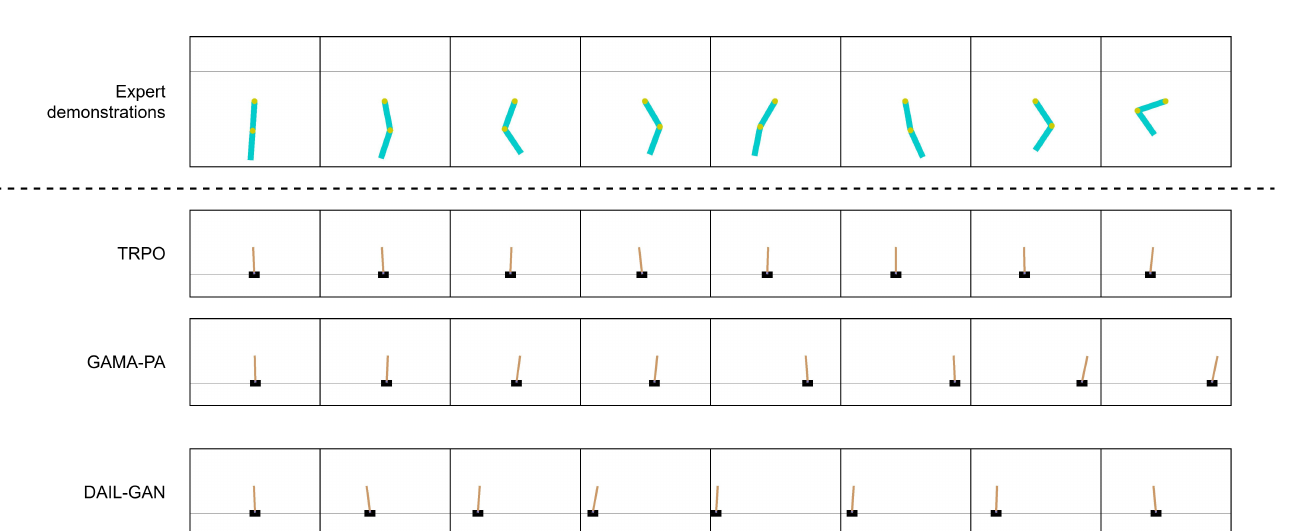
Figure 5. Pendulum–CartPole.